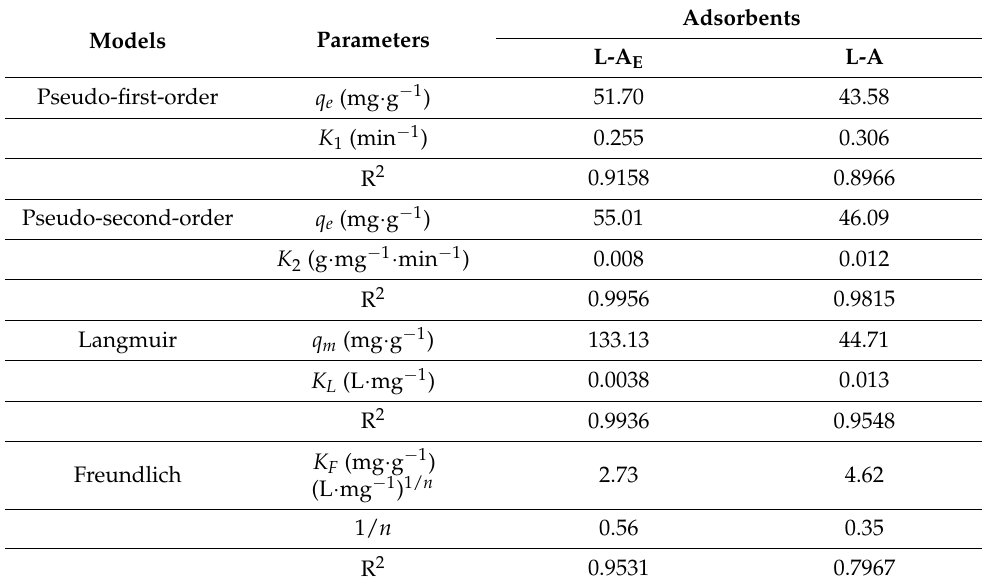
Table 1. Kinetics and isothermal model parameters of phosphate adsorption on L-A E and L-A.